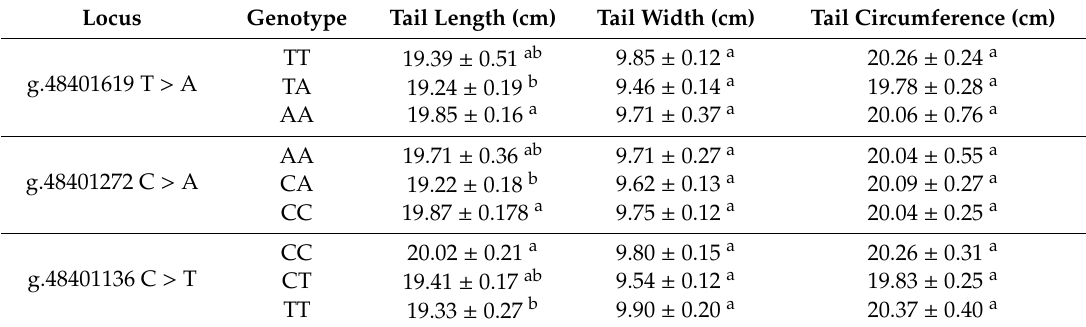
Table 2. Association of different SNP genotypes with tail type traits in sheep.